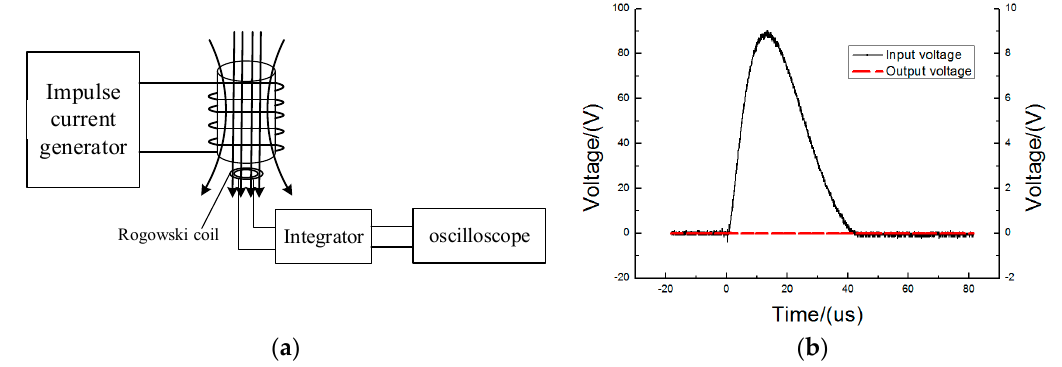
Figure 14. The test of vertical magnetic field interference. ( a ) Testing diagram of vertical magnetic field interference; ( b ) The waveform comparison at vertical magnetic field interference.